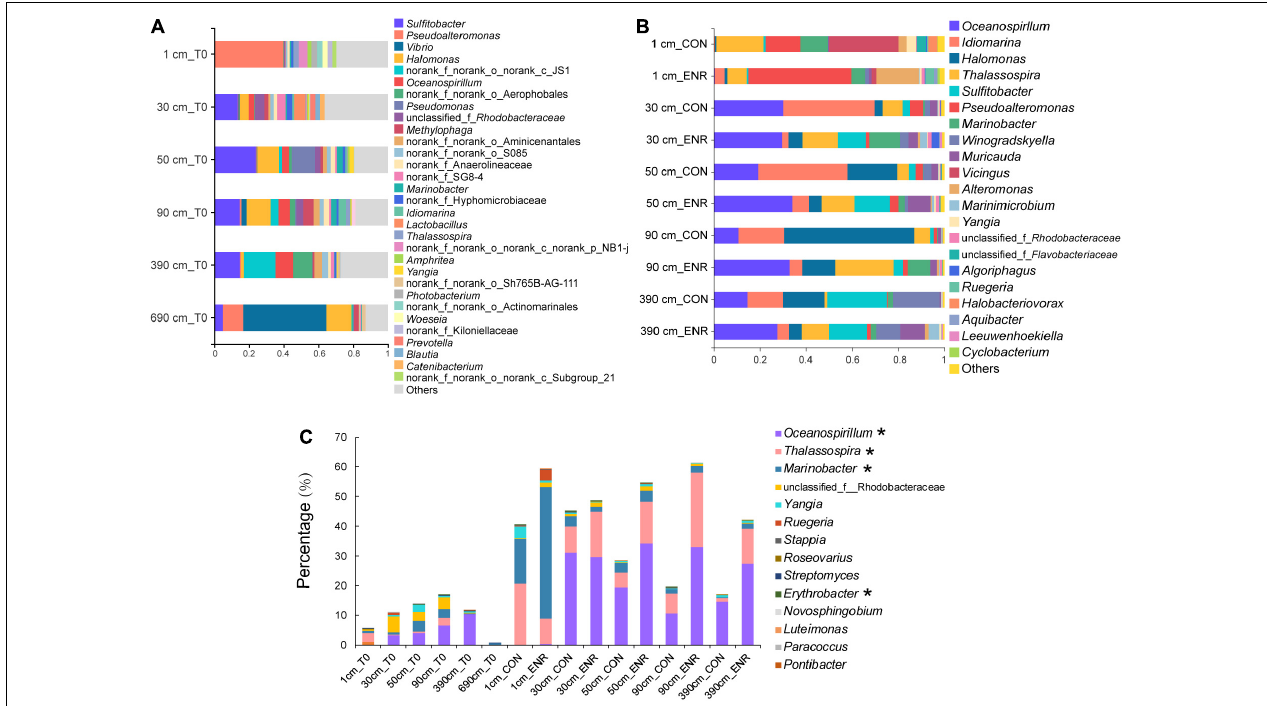
FIGURE 5 | Bacterial community compositions and DMSP-producing genera in natural sediment and enriched samples revealed by 16S rRNA gene amplicon sequencing. (A) Bacterial communities at genera level in natural sediment samples (T0). (B) Bacterial communities in the control (CON) and DMSP-enriched (ENR) samples after enrichment incubation. (C) Known DMSP-producing genera identified from previous studies (Williams et al., 2019; Zheng et al., 2020) and this study (marked with *) in T0, CON, and ENR